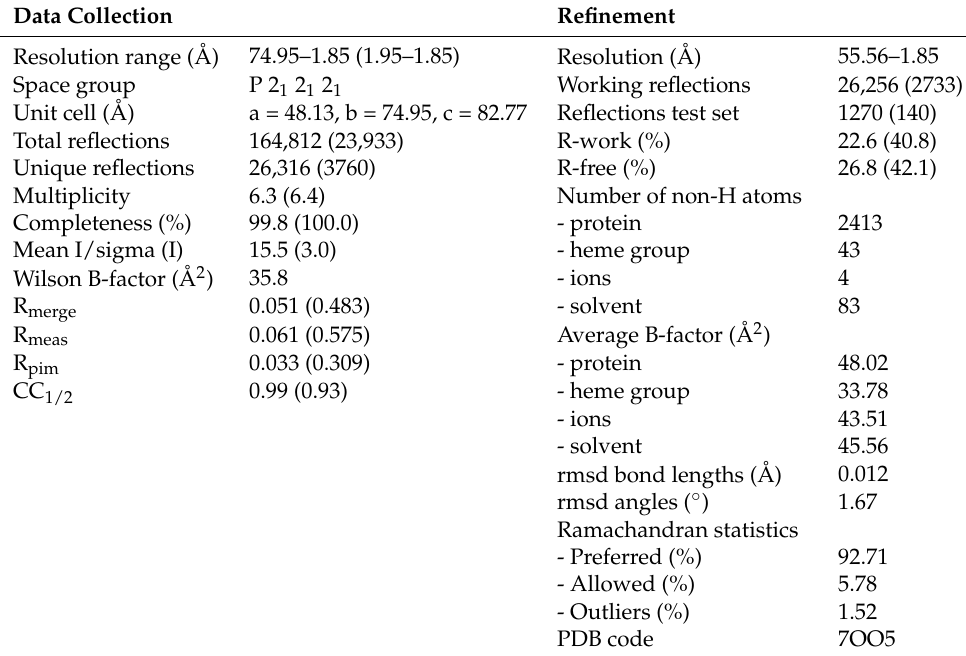
Table 1. Crystallographic data collection and refinement statistics of